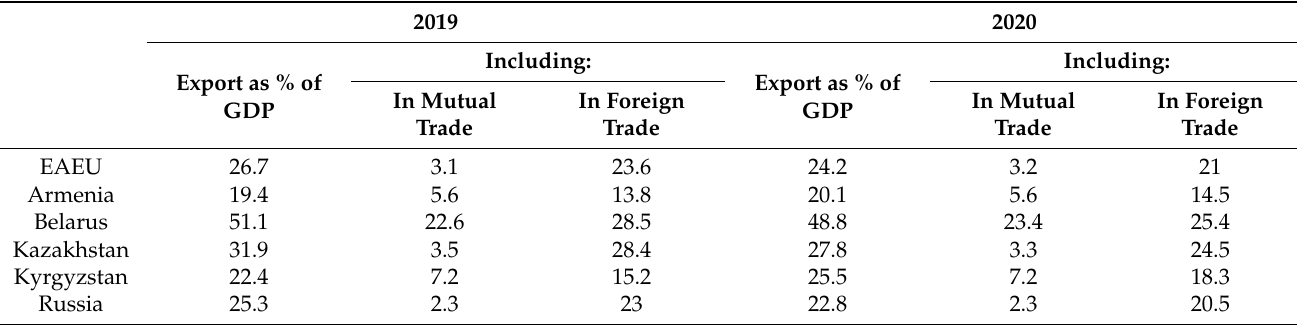
Table 1. Export as a percentage of GDP of countries within the EAEU in foreign and mutual trade, in %.